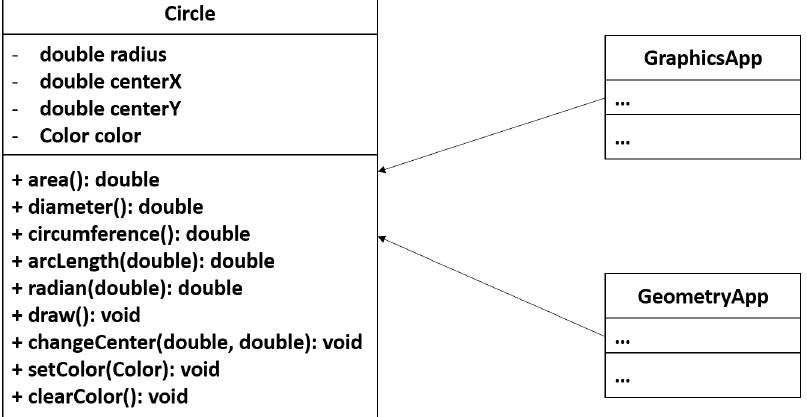
Figure 1. The class Circle and its